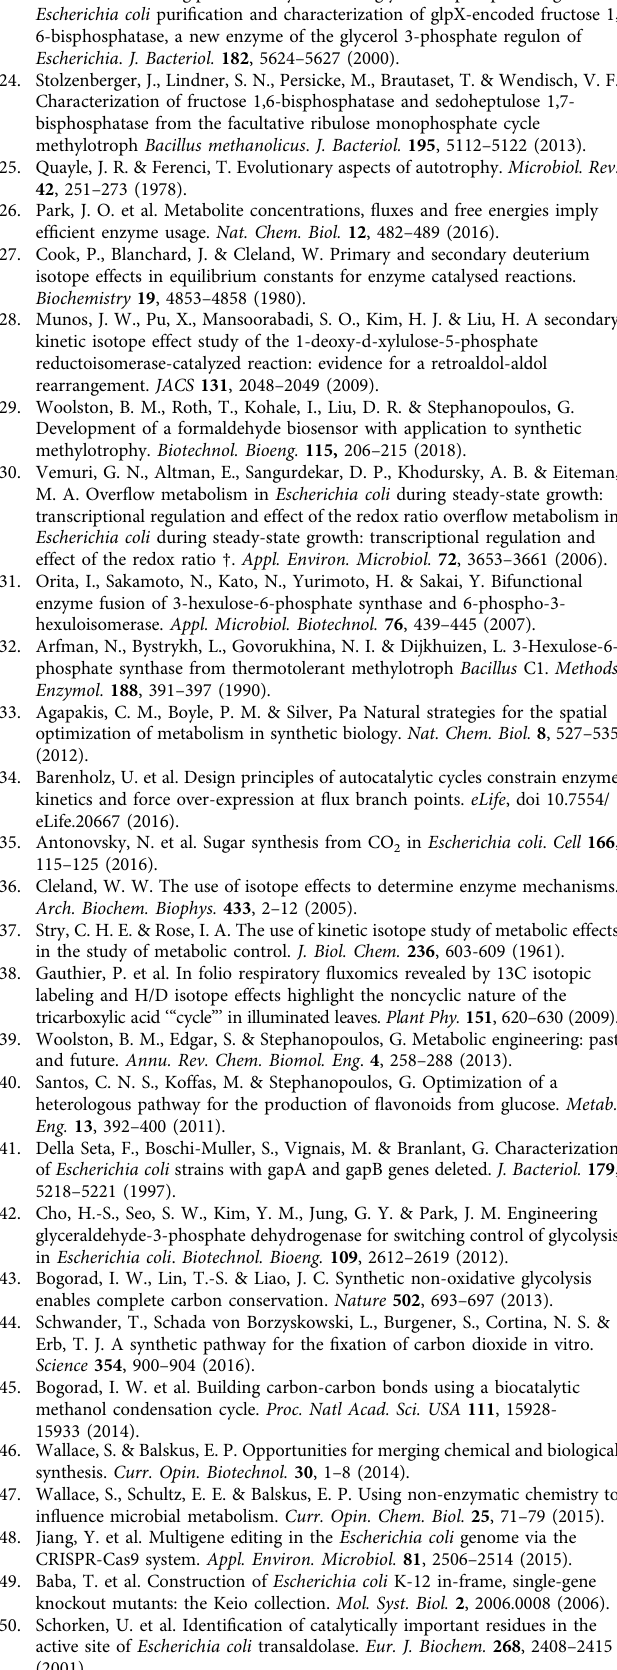
Code availability . The MATLAB code used for calculating Michaelis – Menten parameters is provided as Supplementary Note 3. The Excel fi le used for dynamic formaldehyde simulations is provided as Supplementary Data